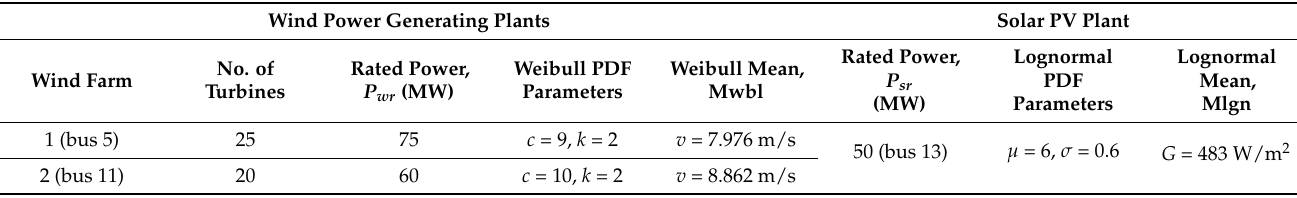
Table 9. PDF parameters of wind power and solar PV plants.